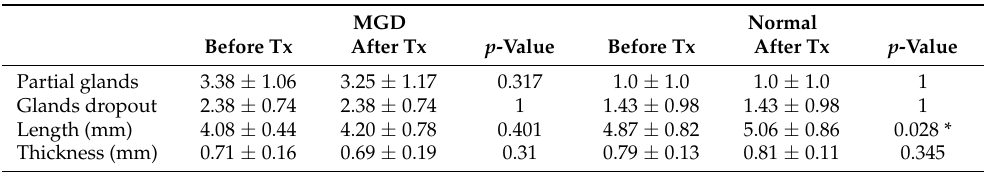
Table 5. Meibography before and after mechanical compression. (Differential analysis by MGD and normal